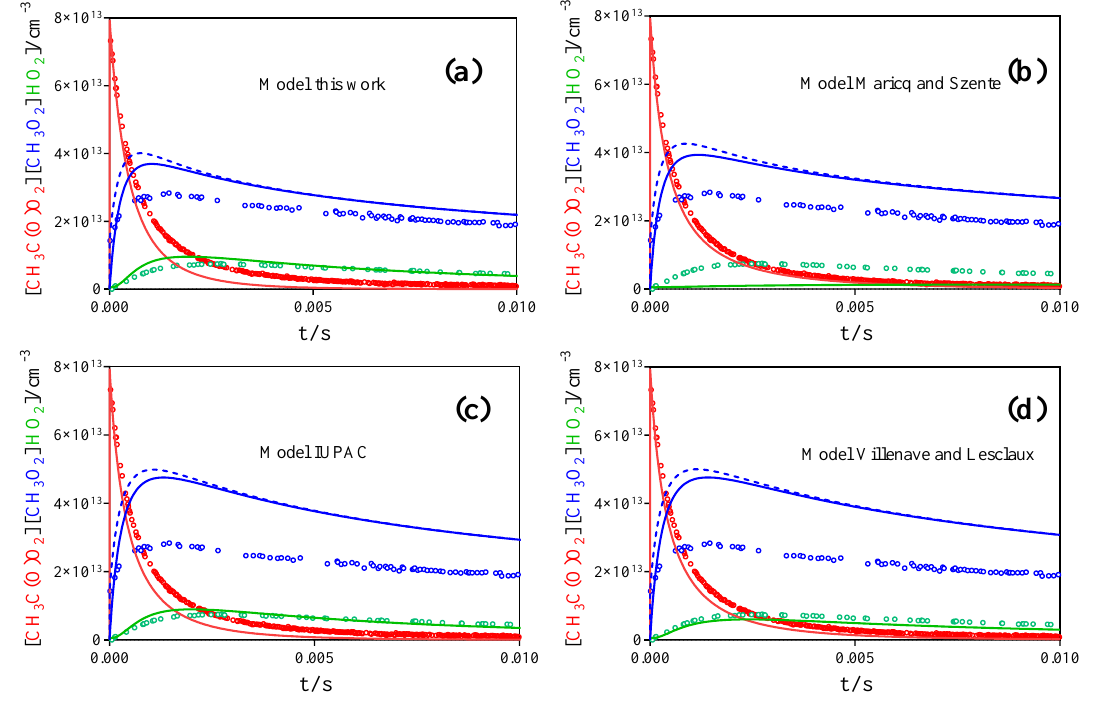
Figure 11. Highest radical concentration from Figure 9: [Cl 2 ] = 1.6 × 10 16 cm − 3 (CH 3 O 2 • in blue,